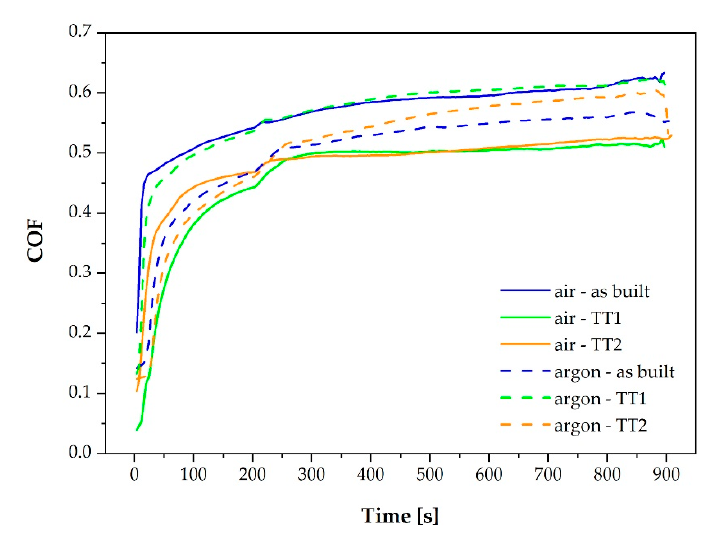
Figure 14. Representation of the coefficient of friction vs. analysis time.